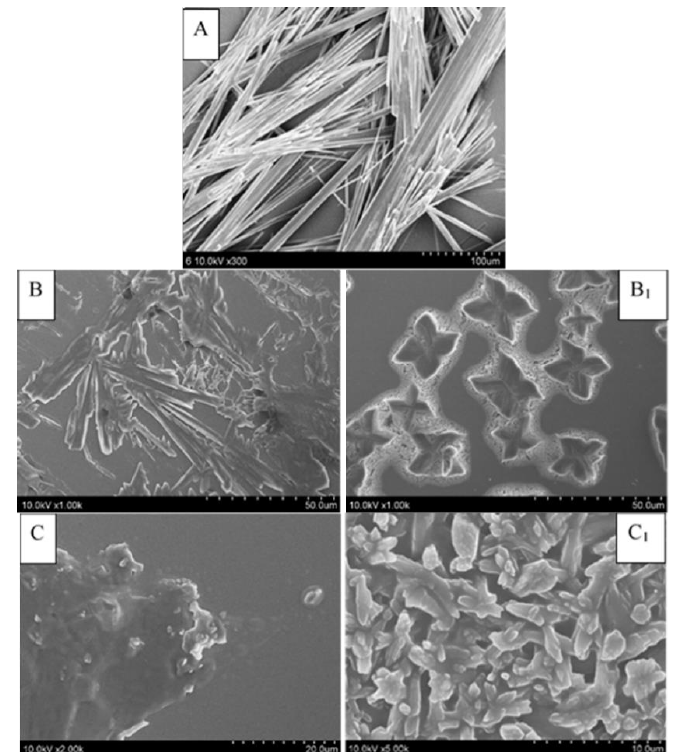
Figure 2. Cryo-field emission SEM photographs of GA, CCFs and the cocrystals ( A ) GA; ( B ) glutaric acid; ( B 1 ) GA-glutaric acid cocrystal; ( C ) succinimide; ( C 1 ) GA-succinimide cocrystal.